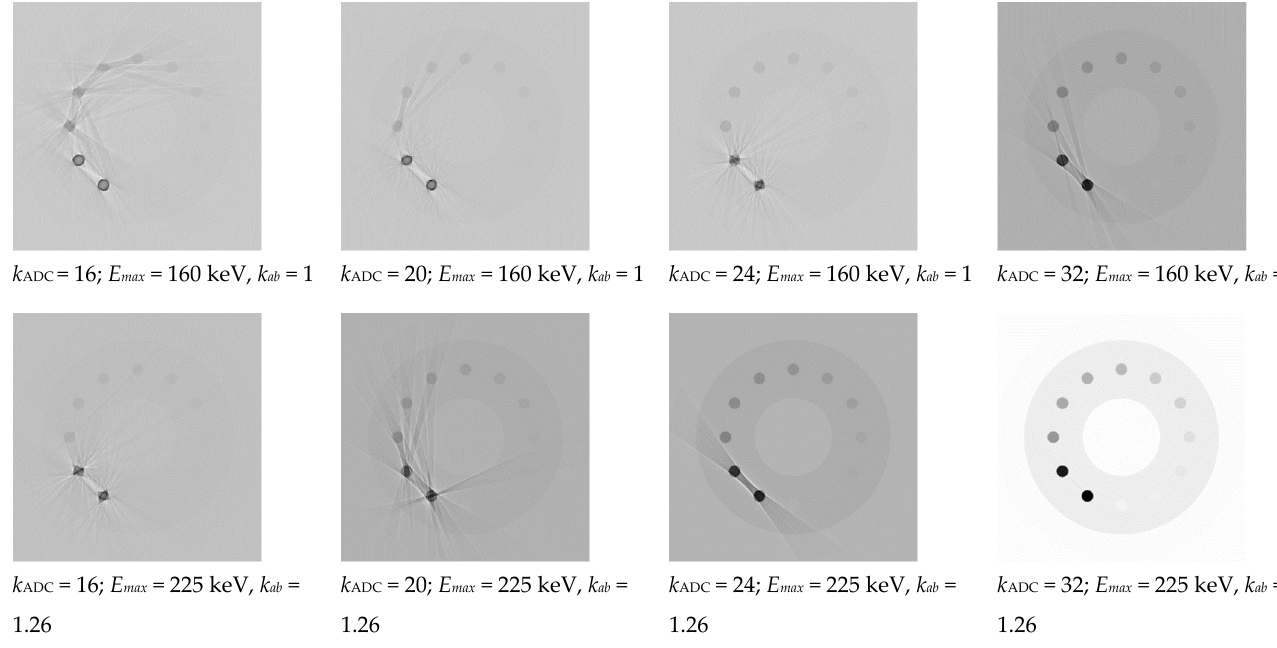
Figure 6. Reconstructed slices of an aluminum cylinder 200 mm in diameter with cylindrical inserts (Table 1, group